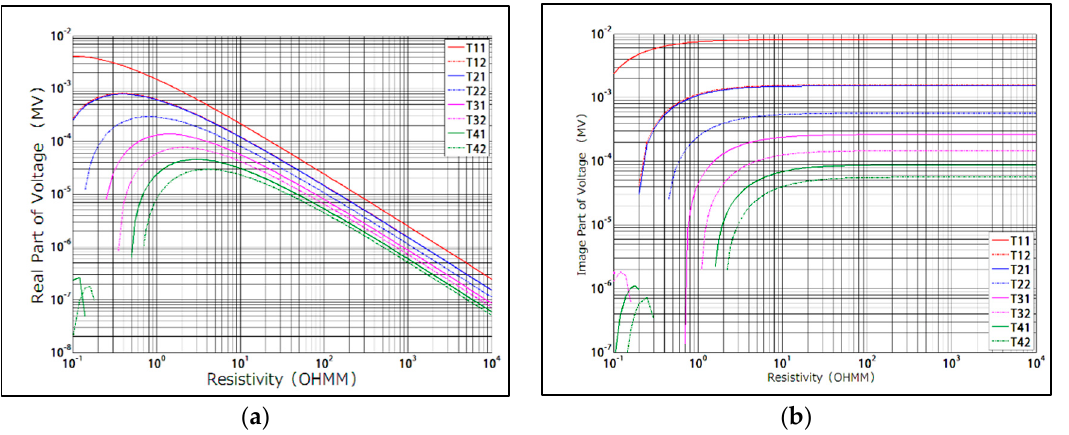
Figure 1. Relationship between induced voltage and formation resistivity under different source spacing: ( a ) Resistivity—real part of voltage correspondence; ( b ) Resistivity—image part of voltage